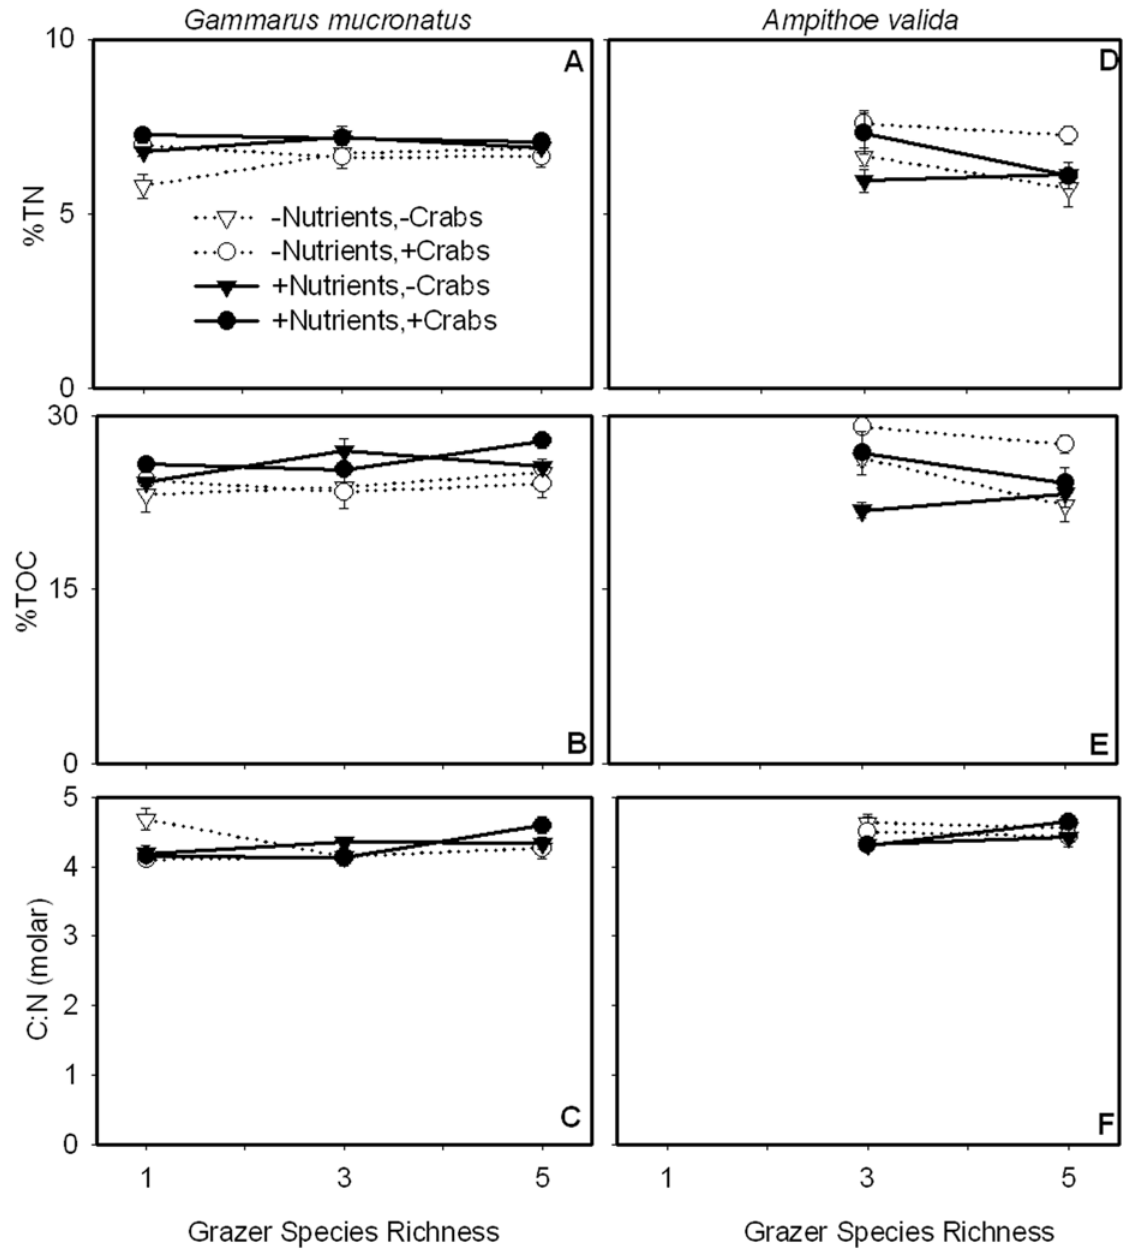
Figure 4. Stoichiometry of G.mucronatus and A.valida . (A–C) Nutrient enrichment increased G. mucronatus %TN and %TOC, but did not affect C:N. (D–F) Nutrient enrichment decreased and crab presence increased the %TOC of A. valida but had no effect on %TN. The C:N of both grazers was insensitive to nutrient and food web manipulations indicating that grazer stoichiometric ratios were less flexible than primary producers.